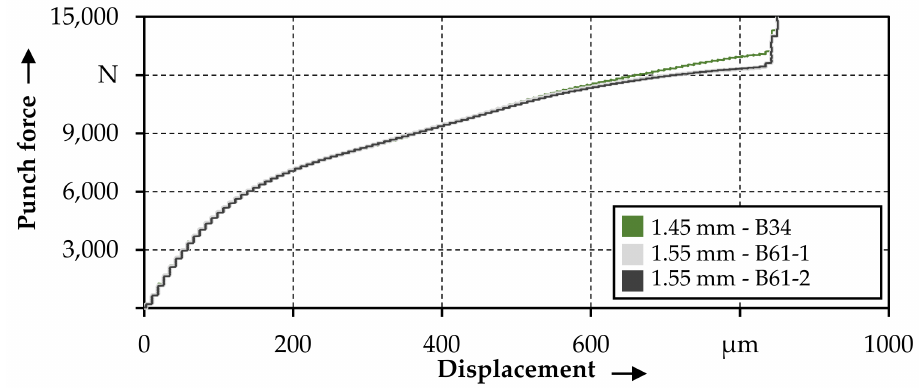
Figure 6. Force-displacement curves in relation to the number and arrangement of the